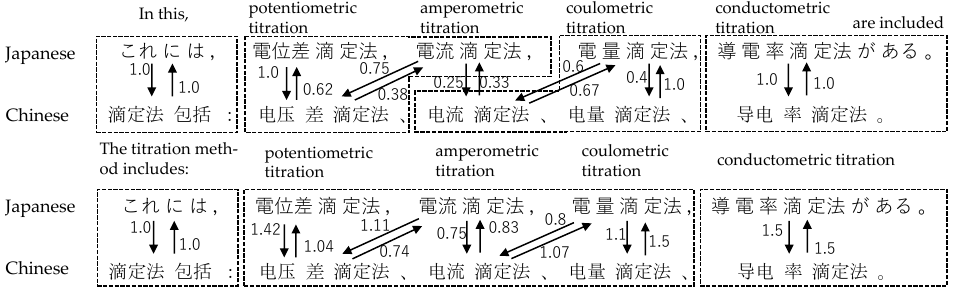
Figure 3. Correction of segments’ correspondence information using common Chinese character information: upper, before correction; lower, after